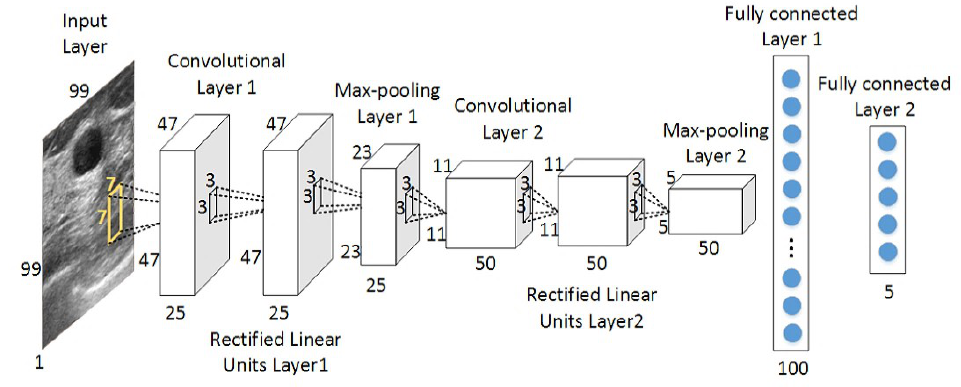
Figure 12. The proposed CNN